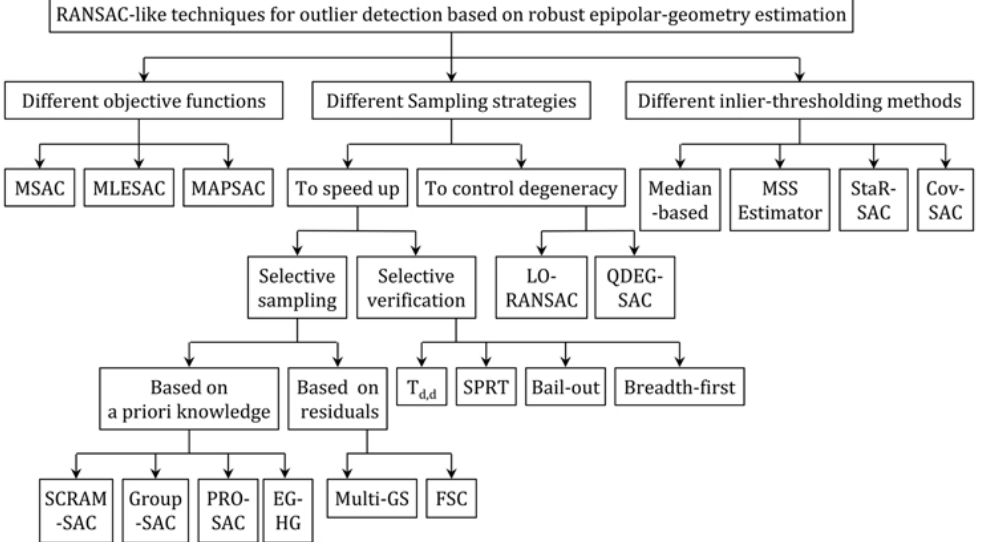
Figure 1. Summary of outlier detection techniques in stereo sparse matching based on robust estimation of epipolar